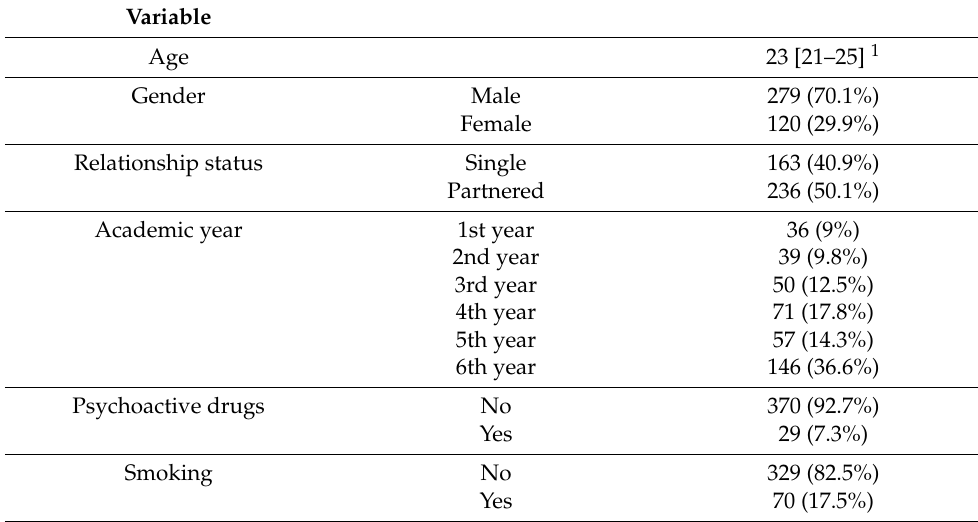
Table 2. Sociodemographic characteristics and health-risk behaviors of participants ( n =